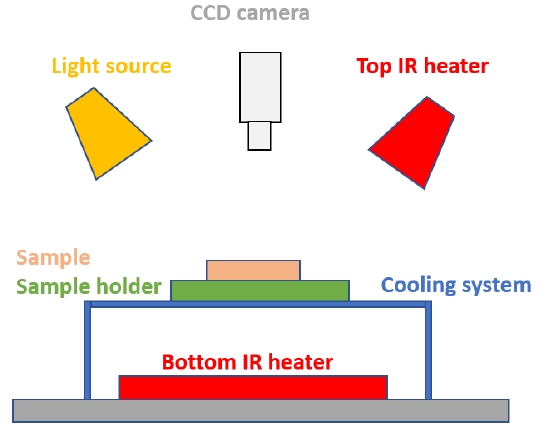
Figure 3. Schematic of experimental setup for warpage